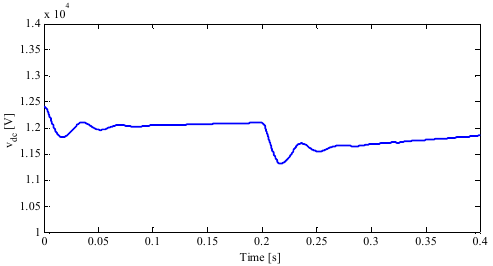
Figure 17. DC ‐ link voltage of MMC with input MMC current variations.